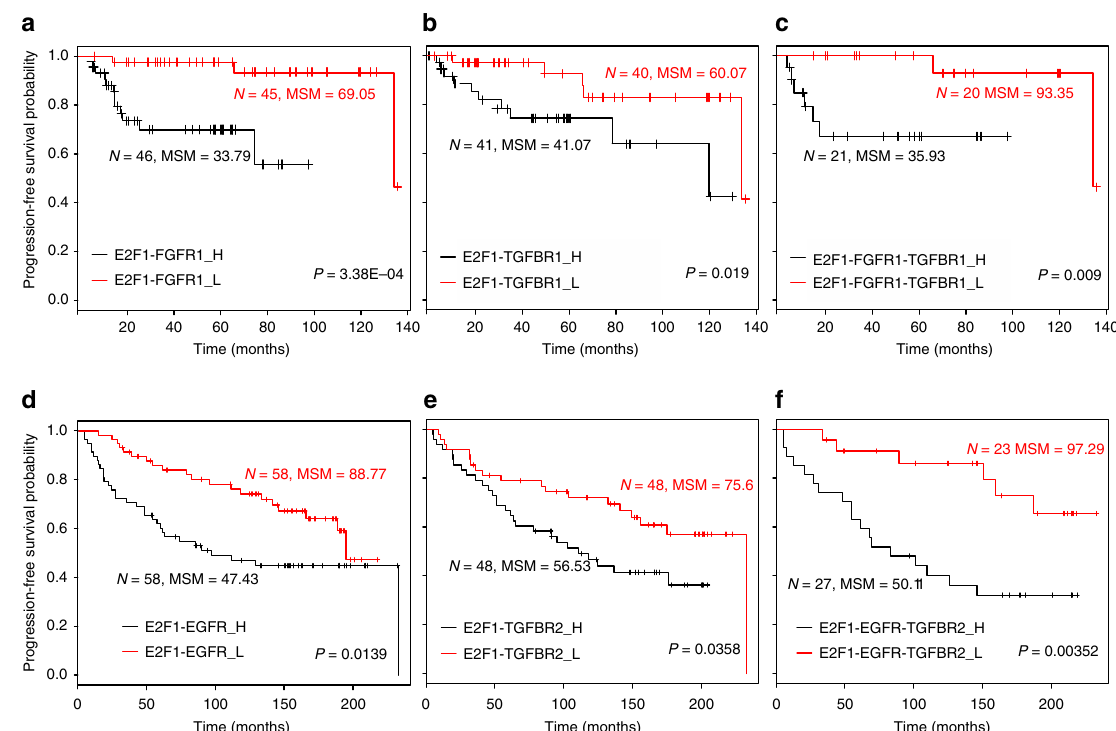
Fig. 7 Kaplan – Meier plots of progression-free survival of patients with bladder and breast cancer. Plots a – c show the survival curves for patients with high and low expression of combined signatures ( E2F1 – FGFR1 ; E2F1 – TGFBR1 ; and E2F1 – FGFR1 – TGFBR1 ) in bladder cancer patients, whereas plots d – f are for the combined signatures of E2F1 – EGFR ; E2F1 – TGFBR2 ; and E2F1 – EGFR – TGFBR2 in breast cancer patients. In both cases, patients with low expression of the molecular signatures have high mean survival times and vice versa. High expression of molecular signature(s) is represented as ‘ _H ’ ( black curve ) and low expression as ‘ _L ’ ( red curve ). ‘ N ’ is the number of patients observed with high/low expression of molecular signatures and ‘ MSM ’ is the mean survival month from the patient group. P -values shown in the fi gures are for log rank